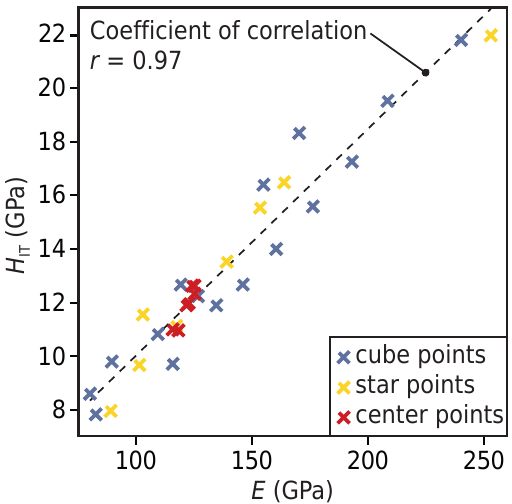
Figure 7. Correlation diagram of Young’s modulus versus indentation hardness of the a-C:H:W coatings. E and H correlate very strongly. This is in accordance with IT H/E ≈ 0 . 1 , which is a typically-assumed ratio for pure amorphous carbon